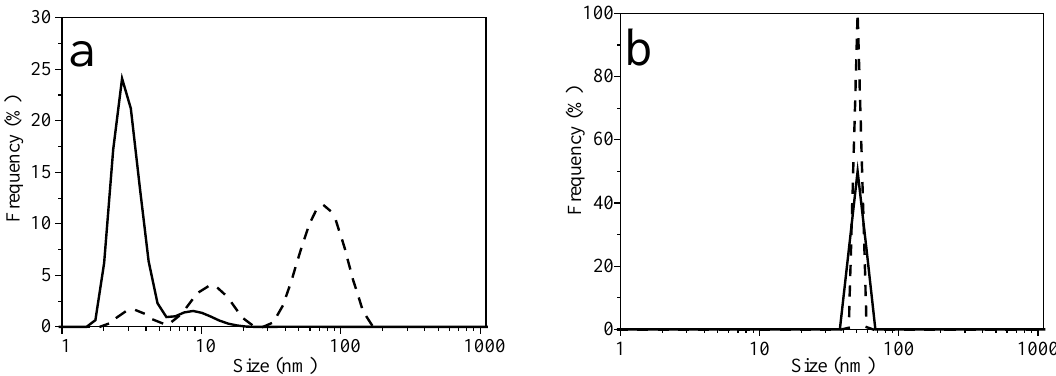
Figure 3. DLS plots for size distribution profiles of AgNPs synthesized at 30 °C: ( a ) AgNPs P103 0% and ( b ) AgNPs P103 0.1%. Intensity size distribution (dashed line). Volume size distribution (continuous line).